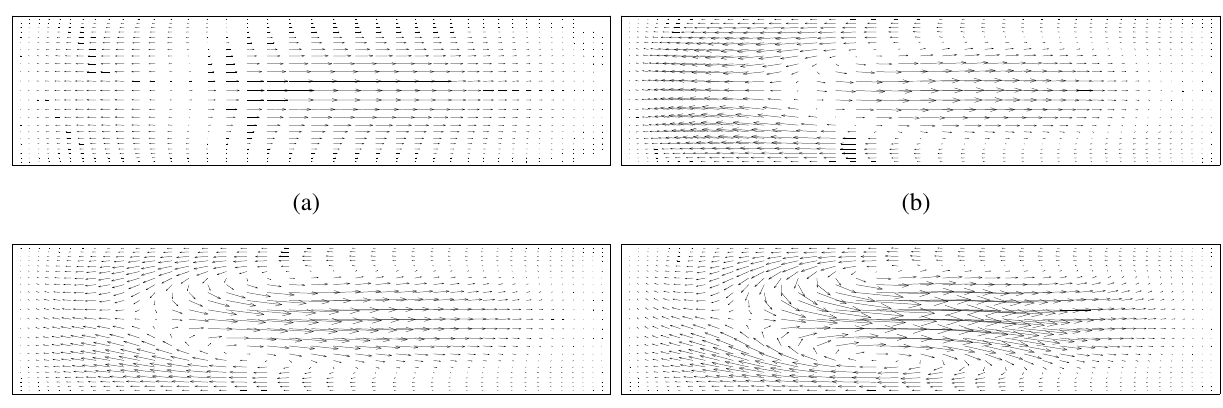
Figure 3. Cross-sectional velocity vectors at z = 0 . 25 L , where L is the length of one geometric period of the channel with α = 0 . 25 and β = 1 / 3 . ( a ) Re = 10 , ( b ) Re = 30 , ( c ) Re = 50 and ( d ) Re = 70